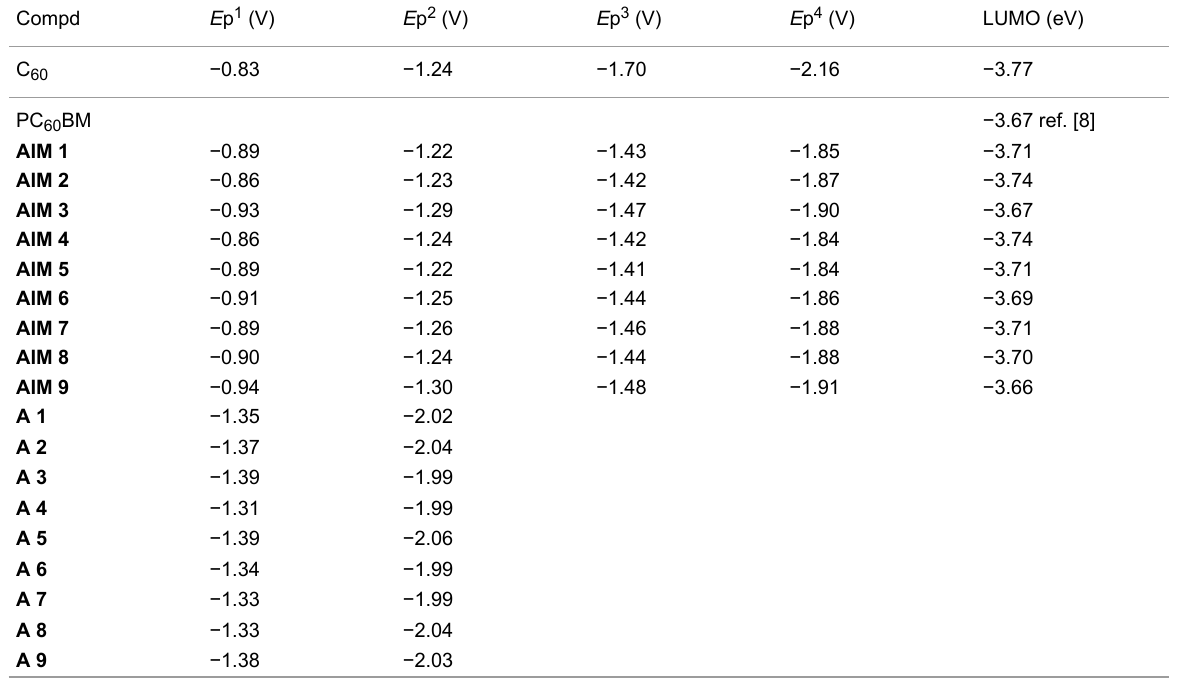
Table 1: Peak potentials a of C 60 , AIM 1 – 9 and A 1 – 9 and LUMO energy levels of AIM 1 – 9 and PCBM.